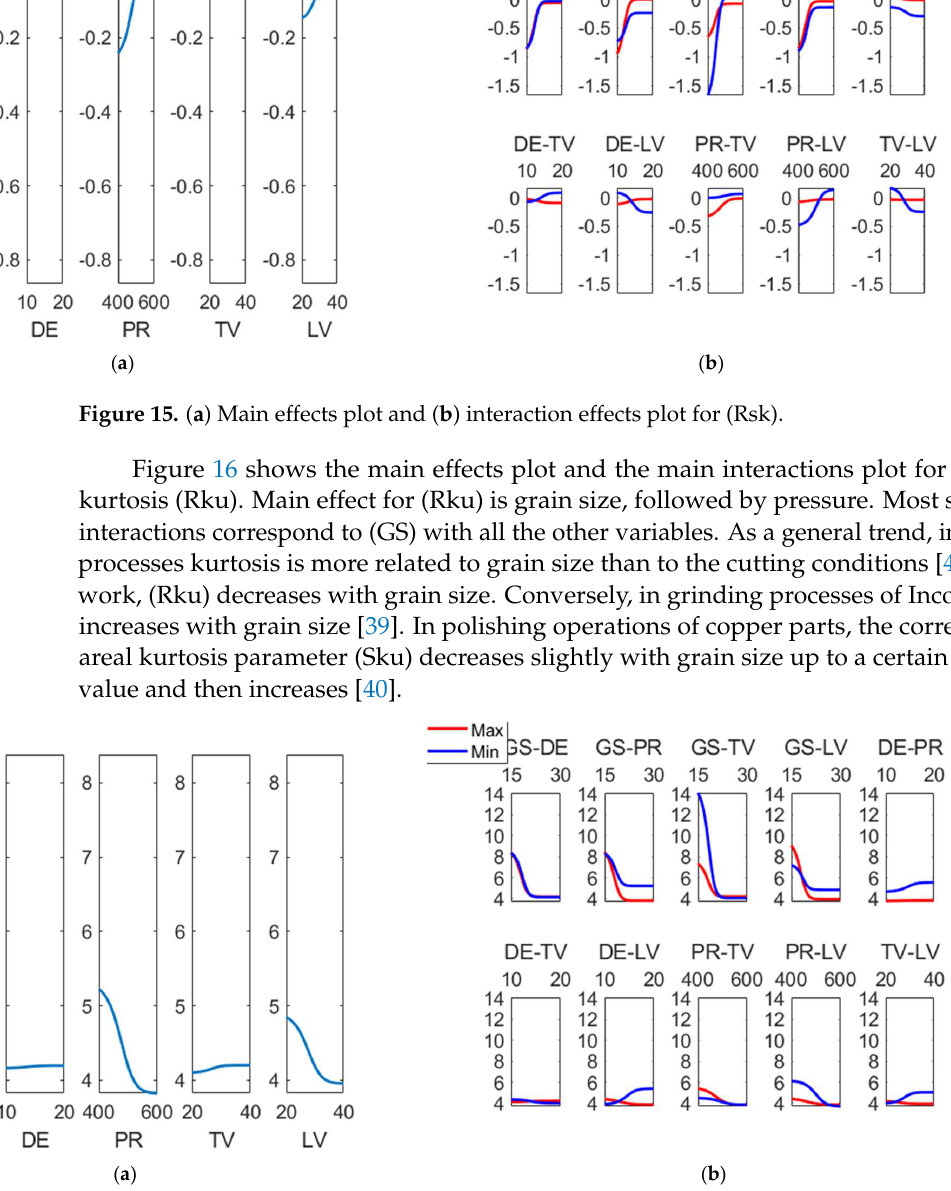
Figure 16. ( a ) Main effects plot and ( b ) interaction effects plot for Rku. The main effects plot and the main interactions plot for (RSm) can be observed in Figure 17. Contrary to what happens to the rest of the responses, in this case main effect is tangential velocity (TV), followed by linear velocity (LV) and by grain size (GS). Main interaction effects correspond to those related to TV, like GS-TV, DE-TV, PR-TV and TV-LV. Parameter (RSm) was reported to decrease after belt grinding and superfinishing (with honing stones) [15].